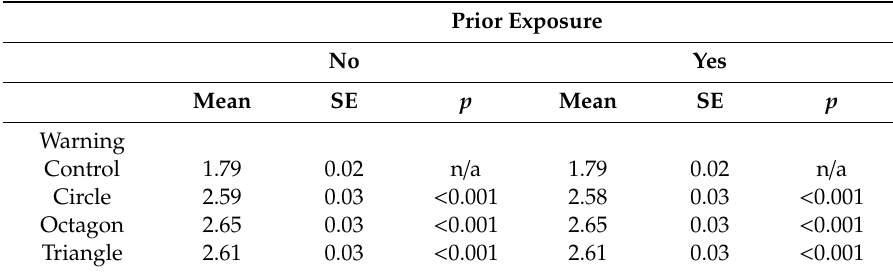
Table A8. Sensitivity analyses: Predicted mean PME, controlling for previous exposure to